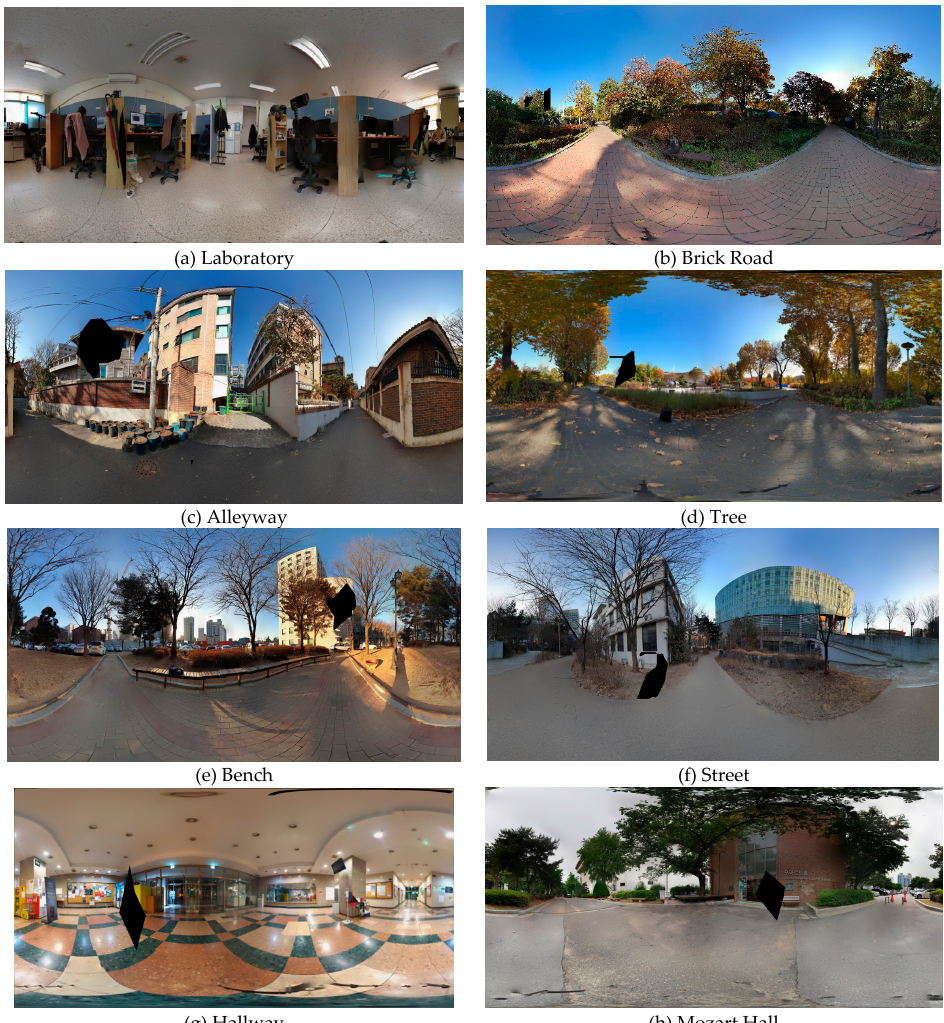
Figure 8. Equirectangular projection images generated from test sets to evaluate different methods. ( a ) Laboratory, ( b ) Brick Road, ( c ) Alleyway, ( d ) Tree, ( e ) Bench, ( f ) Street, ( g ) Hallway, and ( h ) Mozart Hall.